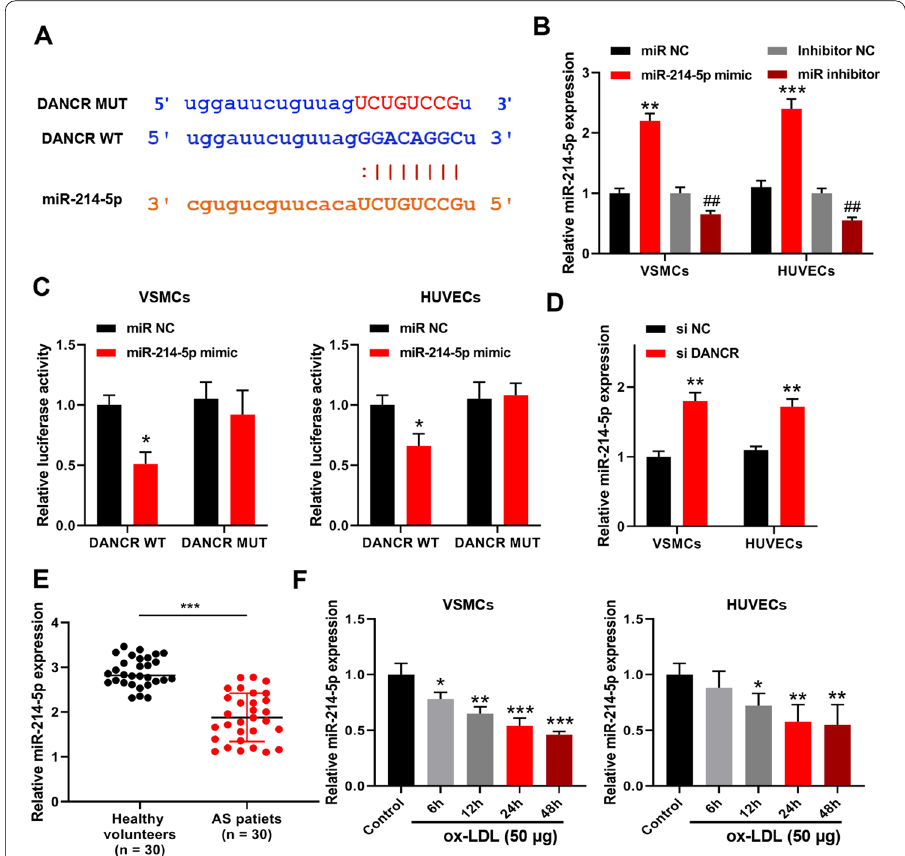
Fig. 3 DANCR served as a ceRNA of miR-214-5p. A The binding site between DANCR and miR-214-5p was predicted by TargetScan. B MiR-214-5p mimics and inhibitor were transfected into VSMCs and HUVECs, and the transfection efficiencies were confirmed by qRT-PCR. C Luciferase reporter assay. D VSMCs and HUVECs were transfected with si-DANCR or si-NC, and miR-214-5p expression was detected by qRT-PCR. E MiR-214-5p expression in blood samples of AS patients was evaluated by qRT-PCR. F VSMCs and HUVECs were subjected to 50 μg/ml ox-LDL for different times. MiR-214-5p expression was evaluated by qRT-PCR. Each experiment was repeated three independent times. *p < 0.05, and **p < 0.01 vs. miR-NC or control group; ## p < 0.01